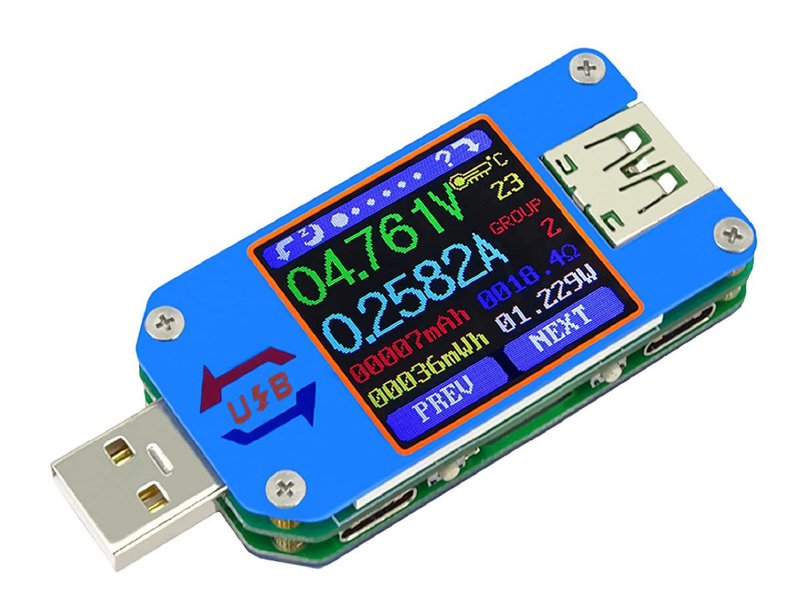
Figure 4. USB Power Meter Tester used to estimate power consumption.